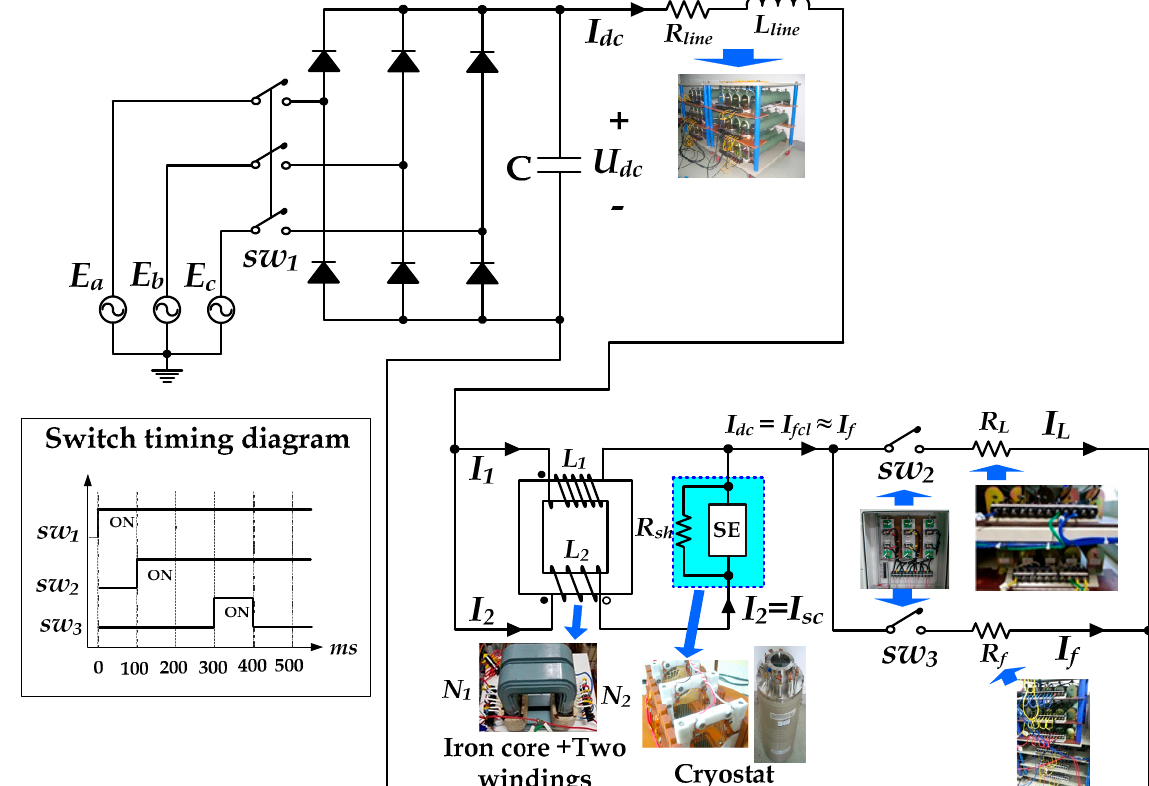
Figure 4. Experimental circuit used to simulate a short circuit in the SFCL using two parallel flux-coupled coils.